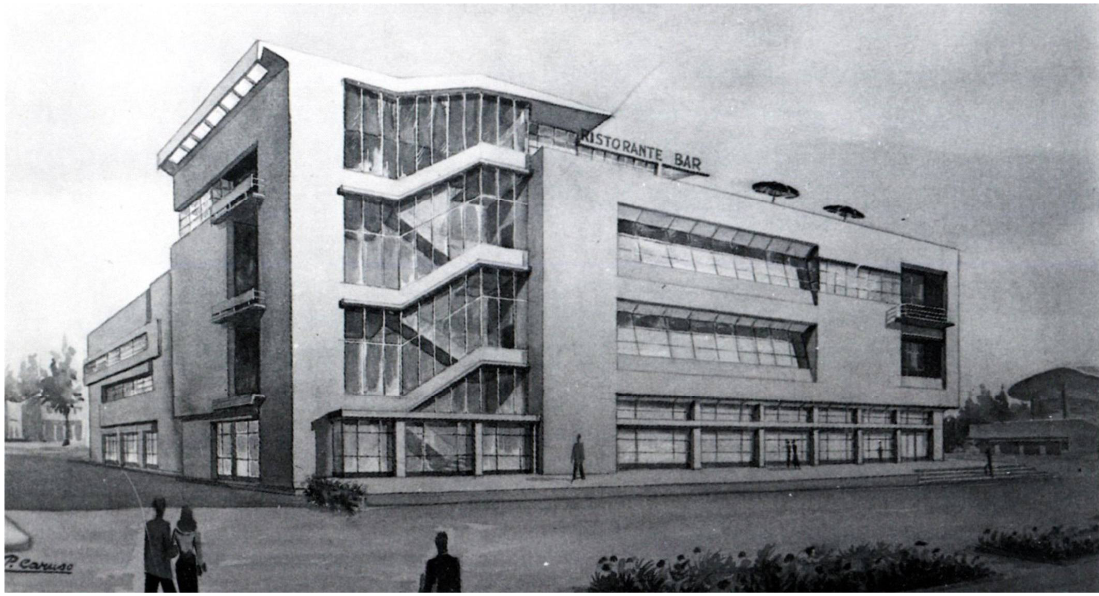
Figure 6. Electricity Pavilion, Arch. Paolo Caruso,